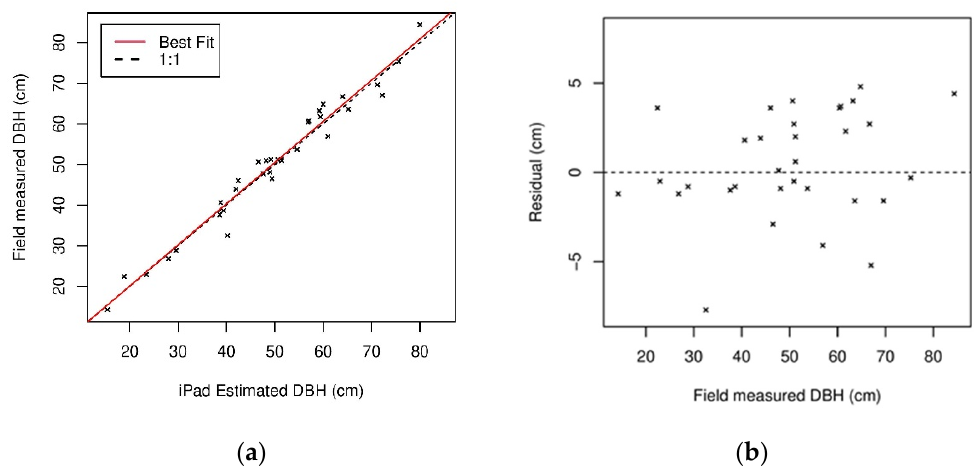
Figure 16. A DBH comparison between iPad LiDAR-derived and field measured data in an urban forest: ( a ) regression plots for DBH from iPad LiDAR, and ( b ) residuals for the estimated field measured DBH.